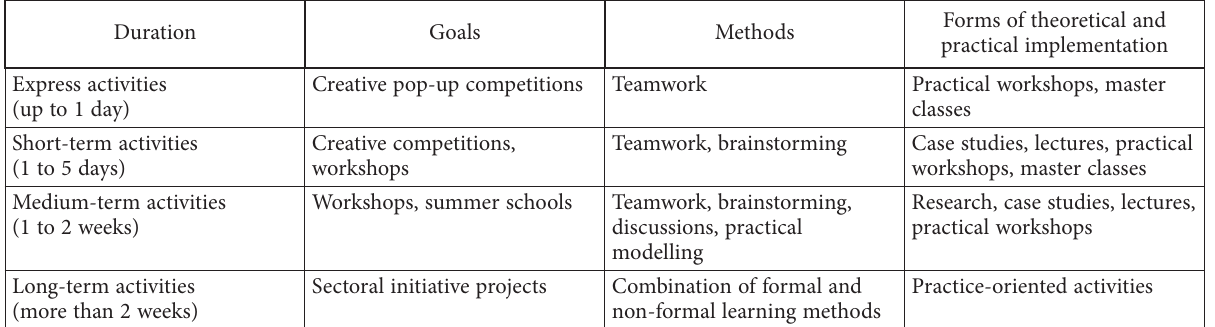
Table 1. Range of non-formal learning